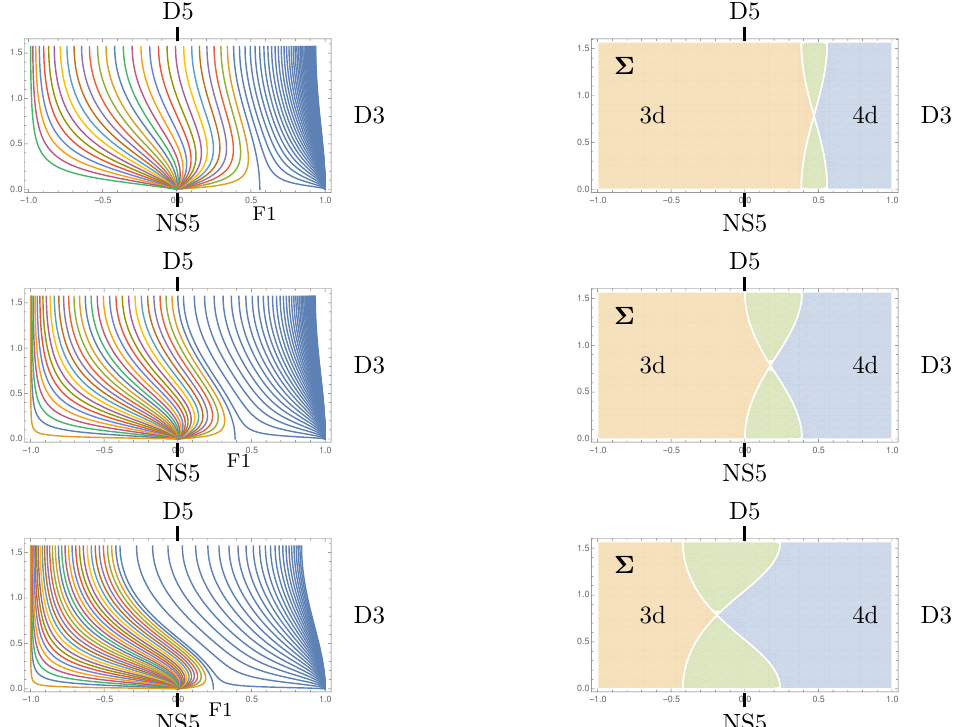
Figure 14. Left: D5 0 -brane embeddings in the D5/NS5 N = 4 SYM BCFT (4.63) with Σ a strip, from top to bottom for N 5 /K ∈ { 4 , 2 , 1 } . The horizontal axis is tanh(Re( z )) , the vertical axis Im( z ) . NS5 0 -brane embeddings are obtained by vertical reflection. Overlaying both leads to the figures on the right: the 3d region hosts D5 0 and NS 0 loop operators and is the 10d version of the ETW brane; the 4d region has no 3d loop operators and is the 10d version of the bulk in figure 13a. The remaining transition regions host one type of 3d loop operator but not